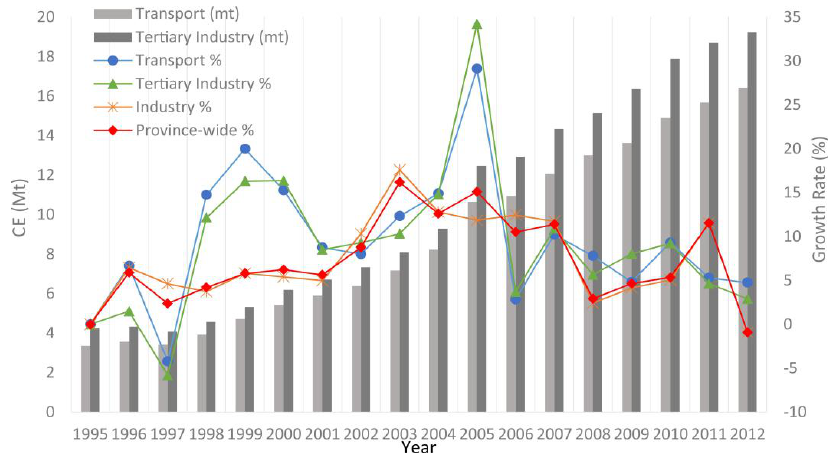
Figure 1. Carbon emissions and its average annual growth rate in Guangdong Province during 1995–2012.